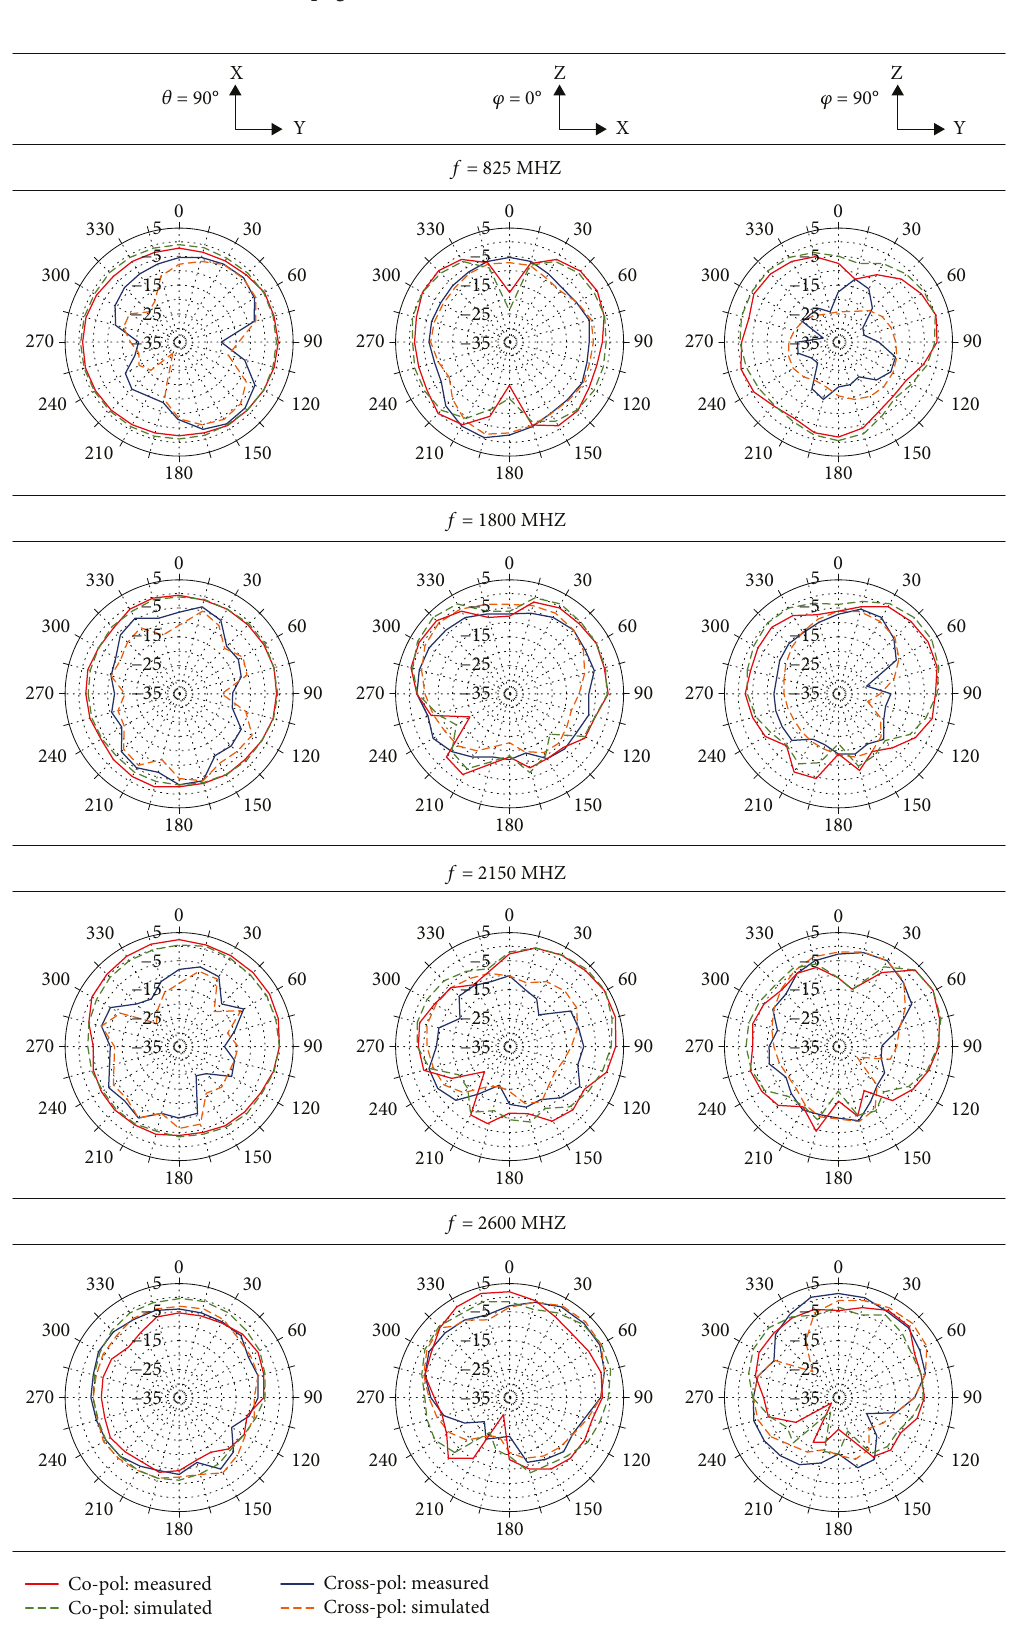
Figure 11: Simulated and measured 2D radiation patterns for the proposed